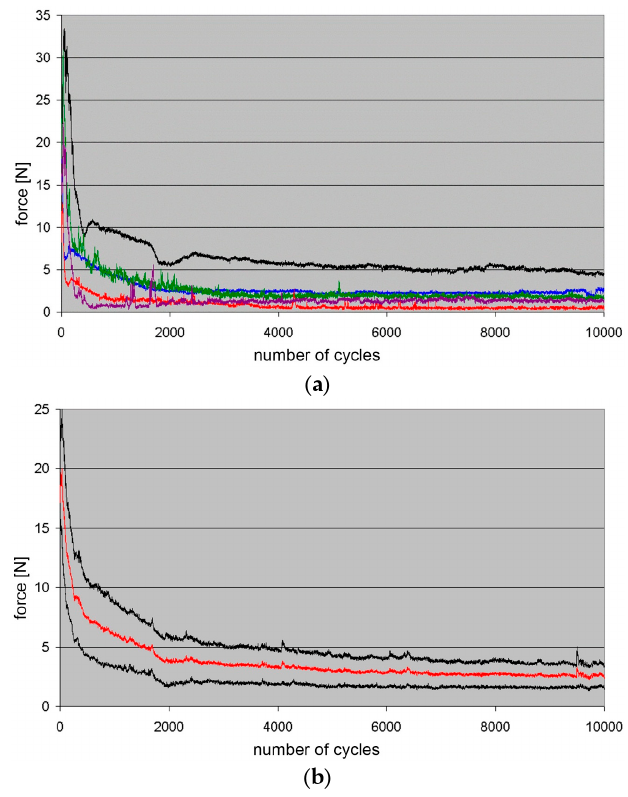
Figure 6. ( a ) Example of five sequences of pull ‐ off forces chosen at random as a portrayal of raw data; ( b ) First phase of the generalised portrayal, taking all 10 sequences of pull ‐ off forces of series D into due account. Red—averaged total curve; black—95% confidence interval.